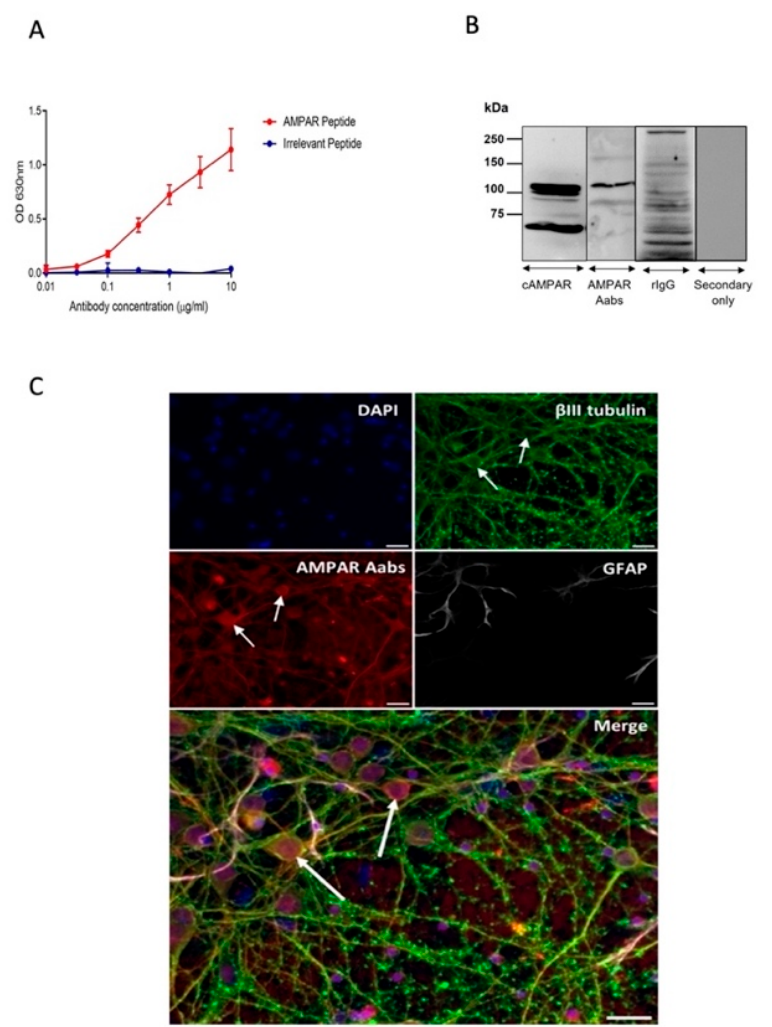
Figure 1. Rabbit anti-AMPAR GluR3B immunogenicity response. ( A ) ELISA of protein A-purified AMPAR (GluR3) Aabs against the GluR3 immunisation peptide or an irrelevant peptide; n = 3 technical replicates. ( B ) Western blot of mouse whole brain lysate probed with a commercial anti-AMPAR antibody (cAMPAR), anti-AMPAR Aabs, a class-specific negative control rIgG (naïve) or secondary antibody only (negative control). Representative blots from n = 3 technical replicates. ( C ) Immunocytochemical staining of fixed primary cortical neuron on cultures. Cells (DIV8) were stained with anti-AMPAR Aabs (red), anti- β III tubulin (green), GFAP (white) and nuclei counterstained with DAPI (blue). Examples of labelling of hippocampal neurons with anti-AMPAR Aabs (red) is indicated by the white arrows. Scale bars = 20 µ m. Representative images from n = 3 technical replicates.